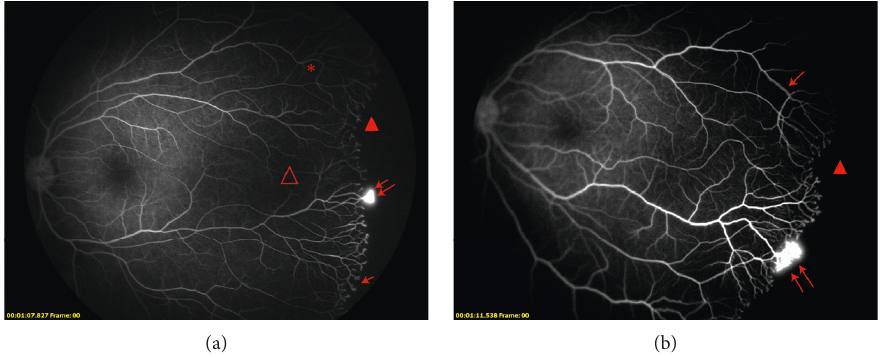
Figure 2: Fluorescein angiographic images of infants receive IVR therapy. (a) Fluorescein angiographic images of an infant (no. 1 in IVR group) born at 28.29 weeks’ gestational age who had zone ii stage 3 ROP with plus disease. Primary intravitreal injection of ranibizumab was performed at 38.86 weeks. Fluorescein angiography at 66.29 weeks PMA exhibits persistent avascular zone (closed arrowhead), vascular leakage (double arrow), vascular blunting (arrow), vascular loops (asterisk), and capillary dropout (open arrowhead). (b) Fluorescein angiographic images of an infant (No. 7 in IVR group) born at 27.86 weeks’ gestational age who had Zone II Stage 3 ROP with plus disease. Primary intravitreal injection of ranibizumab was performed at 39.00 weeks. Fluorescein angiography at 70.86 weeks PMA exhibits persistent avascular zone (closed arrowhead), vascular leakage (double arrow) and vascular dilation